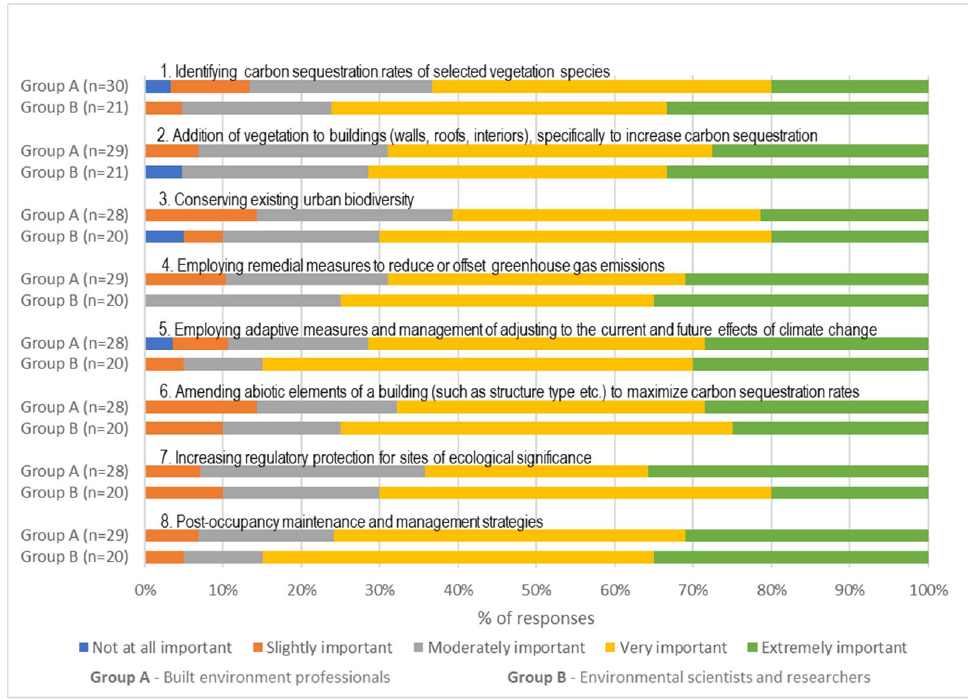
Figure 6. Strategies to increase carbon sequestration through building design.